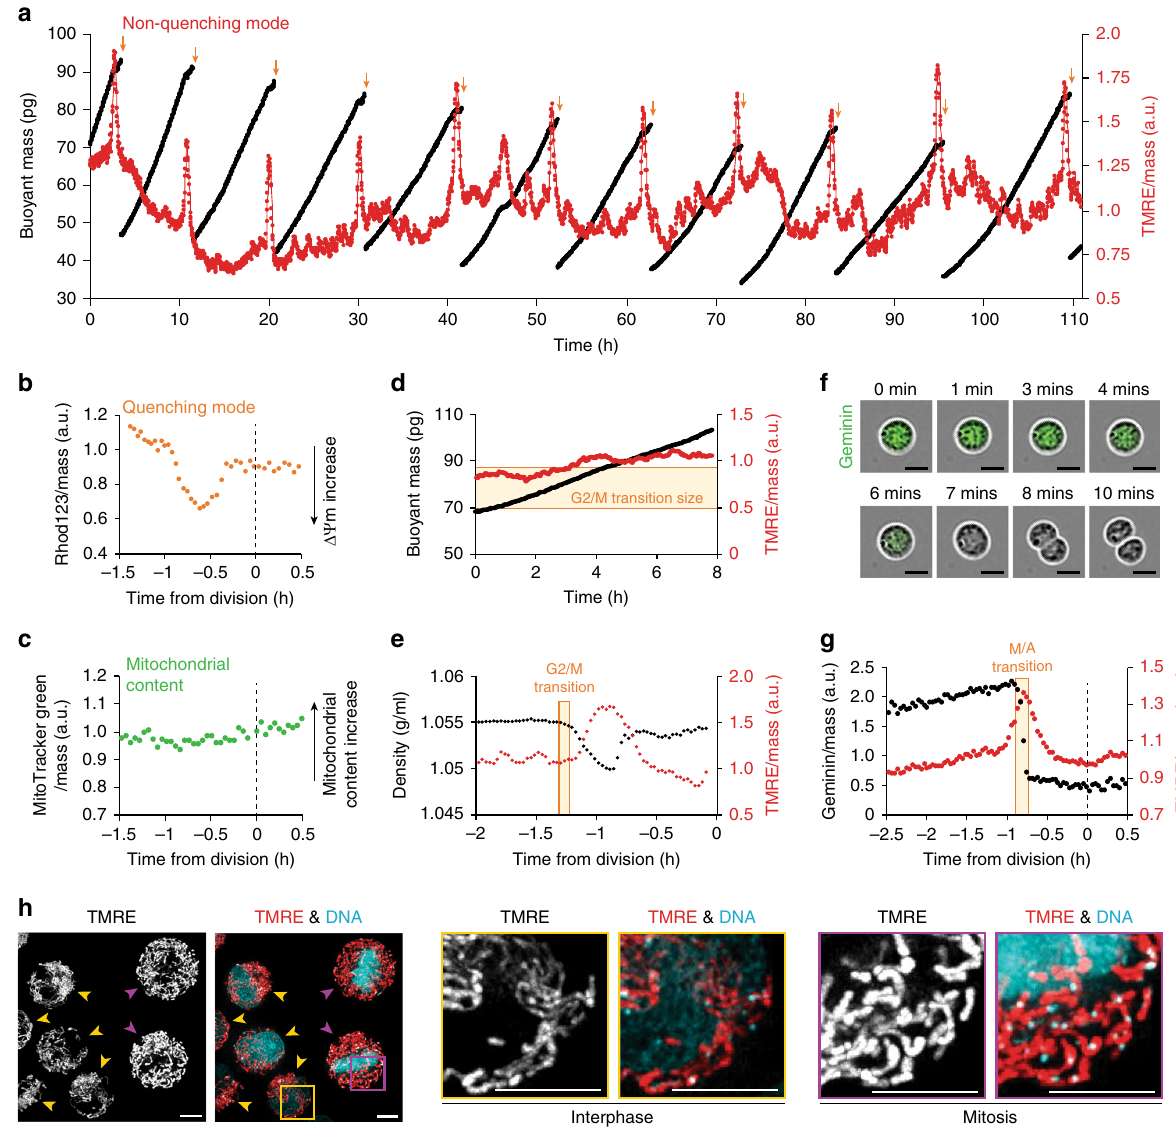
Fig. 1 Mitochondria transiently hyperpolarize during the prophase and metaphase. a Buoyant mass (black) and mass-normalized TMRE (red) trace for a single L1210 cell and its progeny over ten full generations with a measurement interval of 1.9 min. At each cell division (orange arrows), one of the daughter cells is randomly kept and monitored, while the other is discarded. TMRE was used in a non-quenching concentration (10 nM). b Mass-normalized Rhod132 trace for a L1210 cell around cell division. Cells were loaded with a quenching concentration of Rhod123 (10 µ M), washed, and immediately analyzed with no Rhod123 in the culture media. In the quenching mode, the fl uorescence signal behavior is reversed. c Mass-normalized MitoTracker Green (50 nM) trace for a L1210 cell around cell division. d Buoyant mass (black) and mass-normalized TMRE (red) trace for a L1210 cell treated with 2.5 µ M RO-3306 to inhibit mitotic entry. The typical size for mitotic entry is illustrated with a light-yellow area. e Cell density (black) and mass-normalized TMRE (red) trace for a L1210 cell around cell division. Mitotic entry (G2/M transition) is illustrated with a light-yellow area. f Representative phase contrast (gray) and mAG- hGeminin cell cycle reporter (green) images of a L1210 FUCCI cell in mitosis. Experiments were repeated four times independently with similar results. Scale bars: 10 µ m. g Mass-normalized mAG-hGeminin (black) and mass-normalized TMRE (red) trace for a L1210 FUCCI cell around cell division. Metaphase-to-anaphase transition (M/A transition) is illustrated with light-yellow area. h Representative maximum intensity images of live L1210 cells stained with TMRE (red) and PicoGreen (DNA stain, teal). Yellow arrowheads indicate interphase cells, purple arrowheads indicate mitotic cells. Scale bars: 5 µ m. Experiments were repeated four times independently with similar